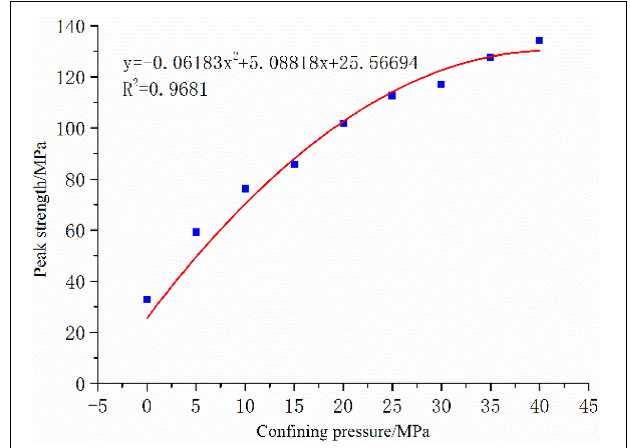
FIGURE 5 | Curve of peak strength vs. confining pressure.